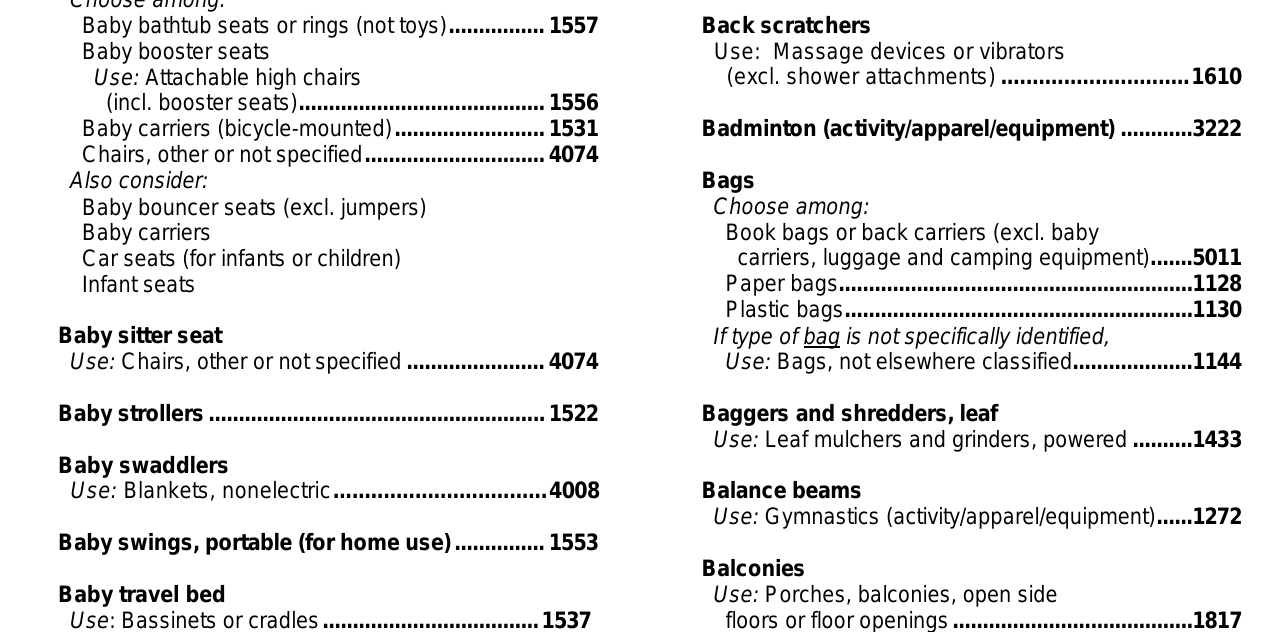
Baby seats or chairs Choose among: Baby booster seats Use: Attachable high chairs